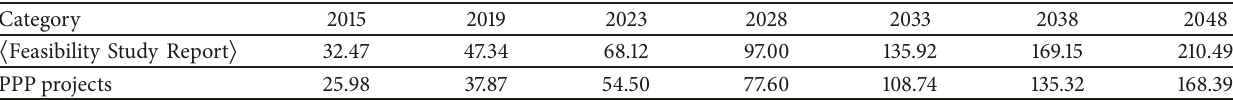
Table 3: The toll revenue of proposed project, unit: million